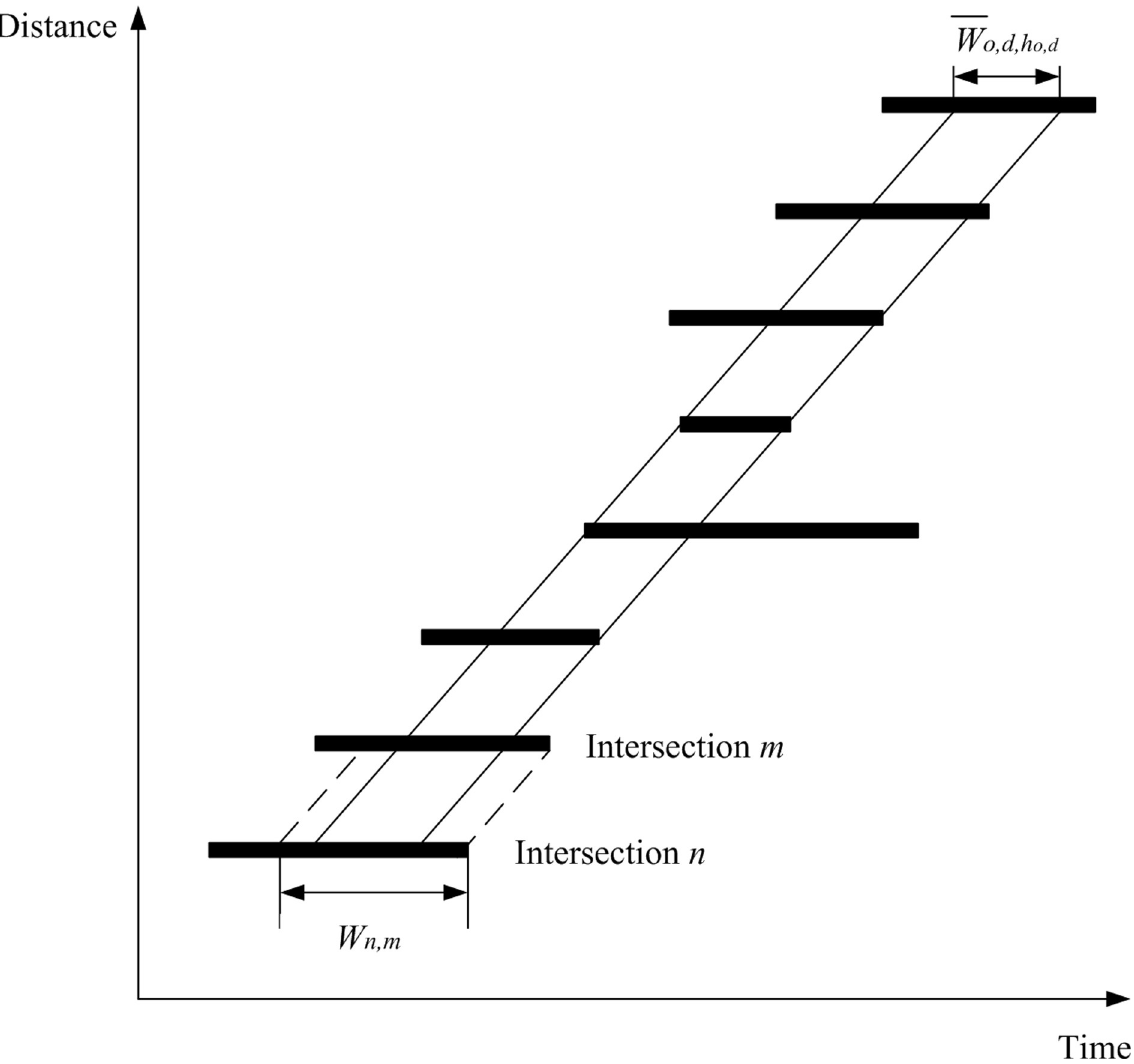
Fig 4. Overall bandwidth W